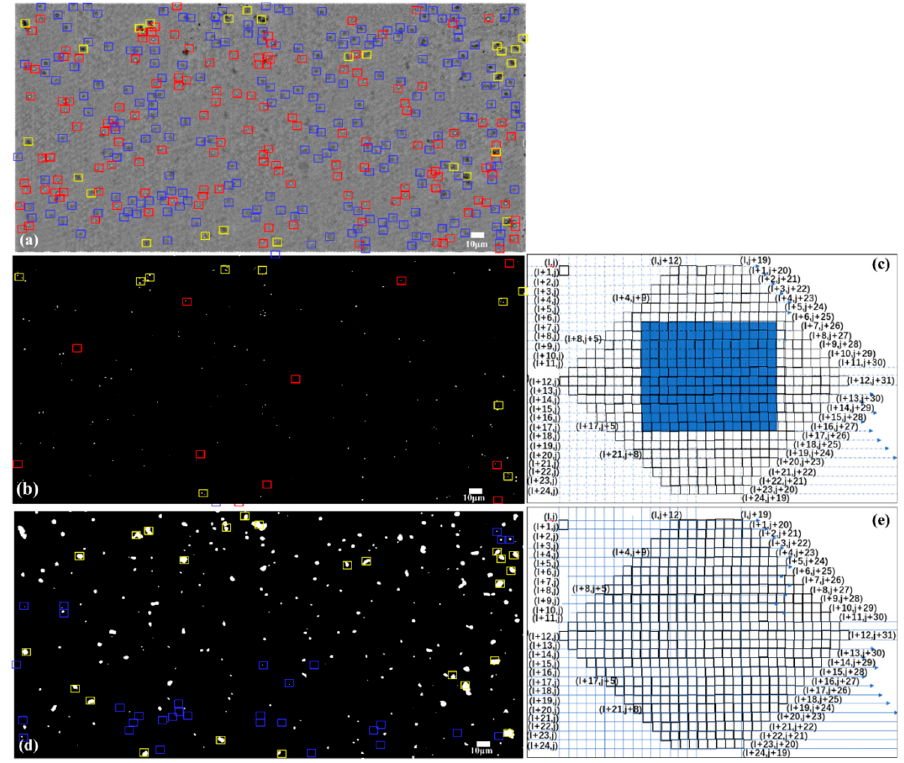
Figure 4 . The yeast cell concentration quantified by the scan window filter. (a) The original grayscale image using AHE processing with the manually labeled live (red) and dead (blue) cells, respectively. (b), (d) The filtered live and dead cells shown by using the live-cell-convolution and the dead-cell-convolution windows. (c), (e) The scan windows for live and dead detection, respectively. The red and blue label in (b, d) indicate false detections, while the yellow labels are the cell clusters.